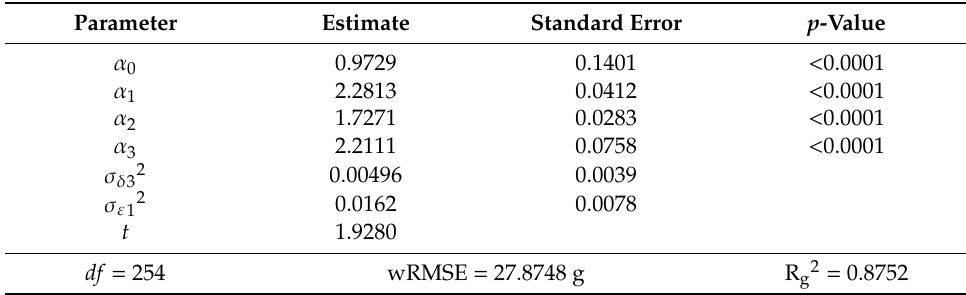
Table 3. Parameters, estimates, standard errors, and p -values for the final branch-level foliage mass model (Equation